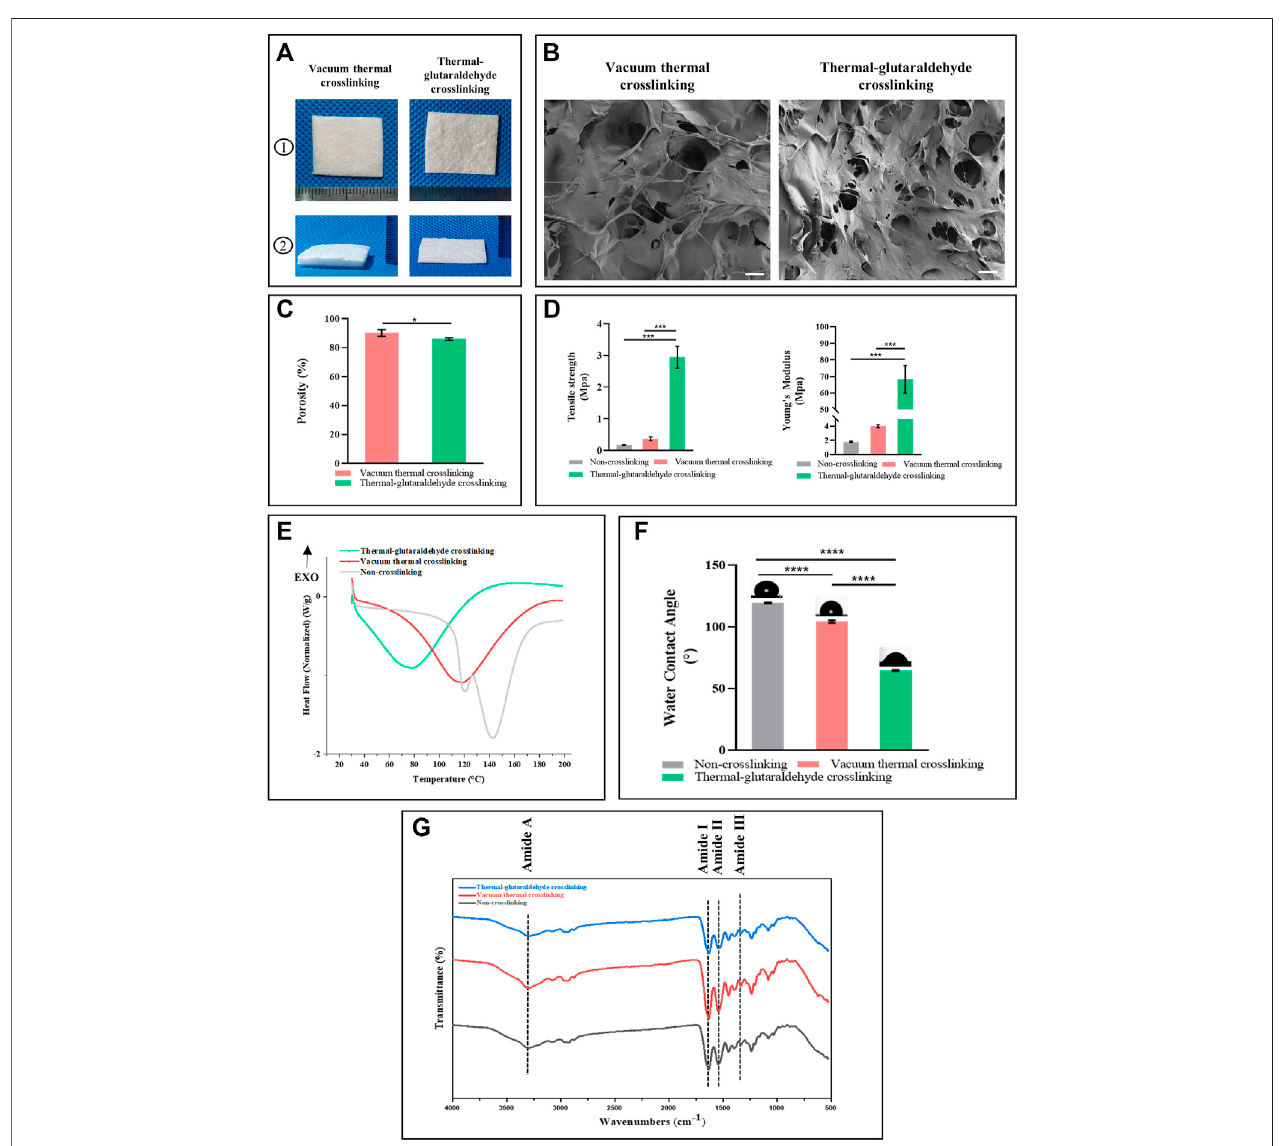
FIGURE 2 | Physicochemical properties of the crosslinked ADM sponges. (A) Gross view of VT-ADM and GA-ADM. (B) scanning electron micrograph images of ADM sponges, bar = 200 μ m. (C) Porosity of ADM sponges ( n = 3 for each group). (D) Mechanical properties including tensile strength and Young ’ s Modulus ( n = 3 for each group). (E) Differential scanning calorimetry of ADM sponges ( n = 3 for each group). (F) Water contact angle of ADM sponges ( n = 3 for each group). (G) FT-IR spectra of ADM sponges. *p < 0.05 , **p < 0.01 , ***p < 0.001 , and ****p <